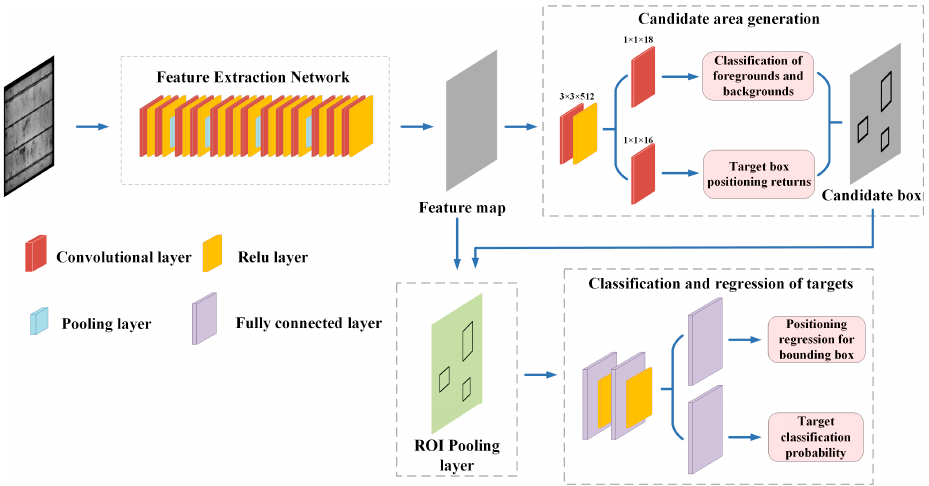
Figure 2. Region-based convolutional neural network (Faster R-CNN) architecture.